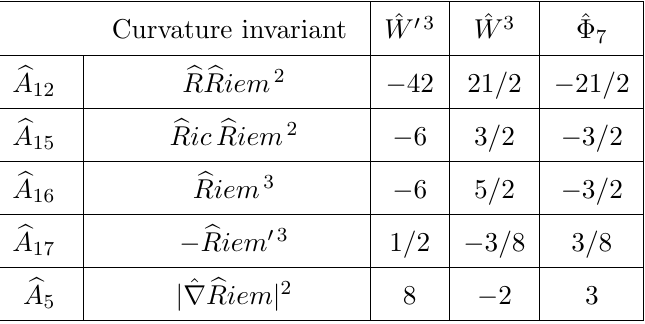
Table 2 . Weyl content of 7D curvature